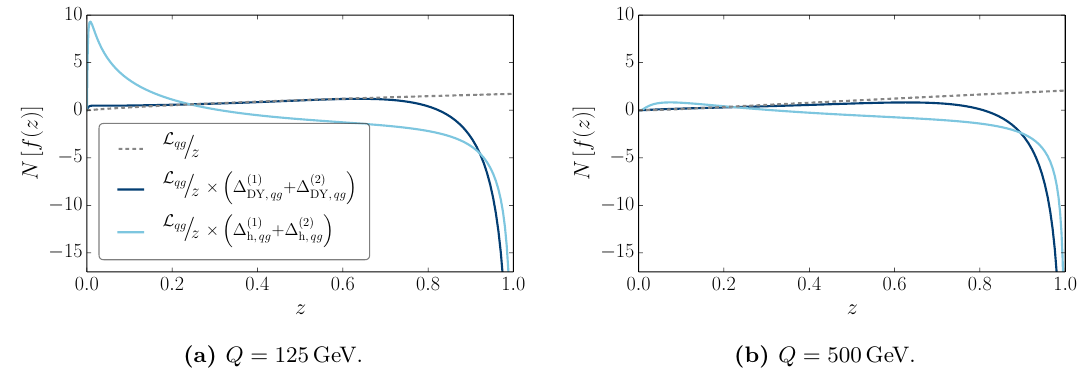
Figure 6. The luminosity function (grey dashed) and its point-by-point multiplication with the coefficient functions up to NNLO (solid), for the qg -channel of DY (dark blue) and single Higgs (light blue) production. All curves are normalized according to eq. (2.16).